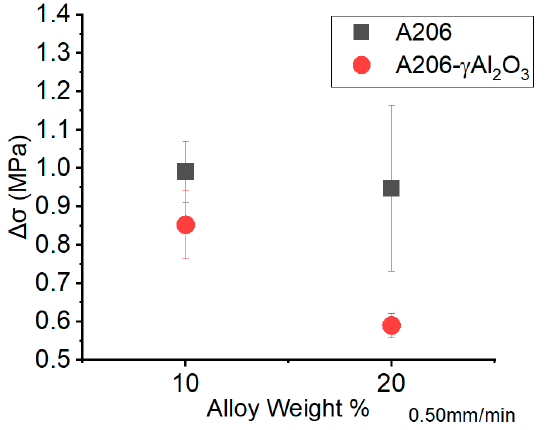
Figure 13. PLC signal amplitude at a 0.500 mm/min strain rate.